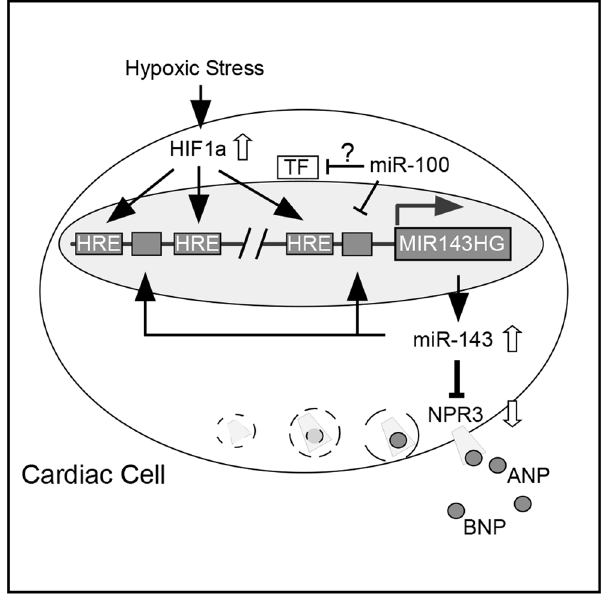
Figure 6. Schematic diagram of hypoxia-induced transcriptional activation of MIR143HG and the proposed microRNA directed transcriptional modification by miR-143 and miR100 in cardiac